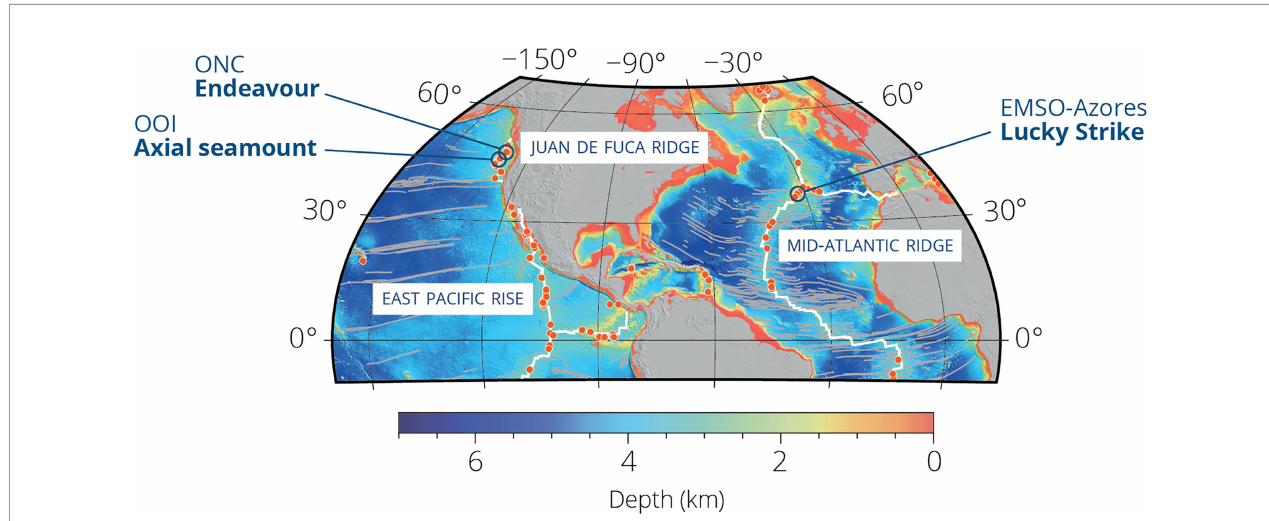
FIGURE 1 | Location of the three currently operating sea fl oor and water column mid-ocean ridges ocean observatories in the Paci fi c and Atlantic oceans. Orange dots represent active known vent fi